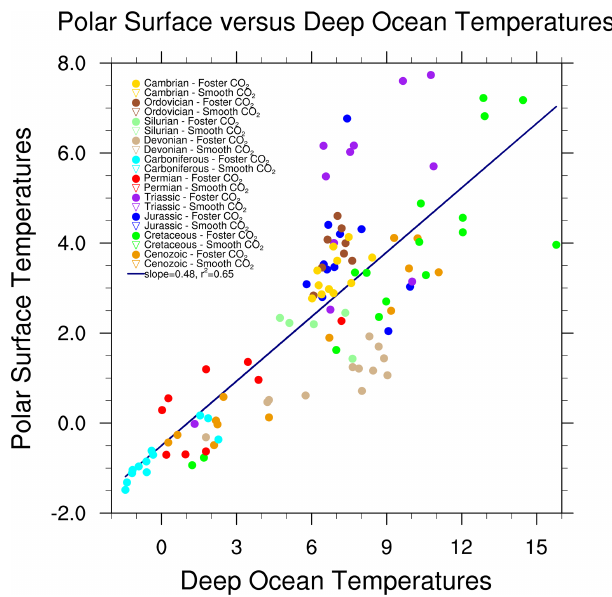
Figure 6. Correlations between deep ocean temperatures and sur- face polar sea surface temperatures. The deep ocean temperatures are defined as the average temperature at the bottom of the model ocean, where the bottom must be deeper than 1000m. The polar sea surface temperatures are the average winter (i.e. northern polar in DJF and southern polar in JJA) sea surface temperature polewards of 60 ◦ . The inverted triangles show the results from the smooth CO 2 simulations and the dots refer to the Foster CO 2 simulations. The colours refer to different geological